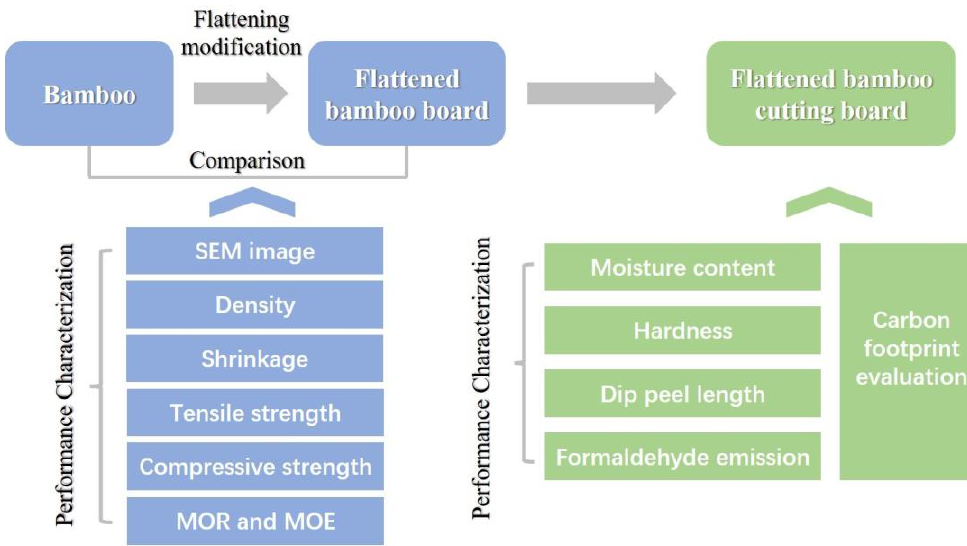
Figure 1. Flowchart of the research method.